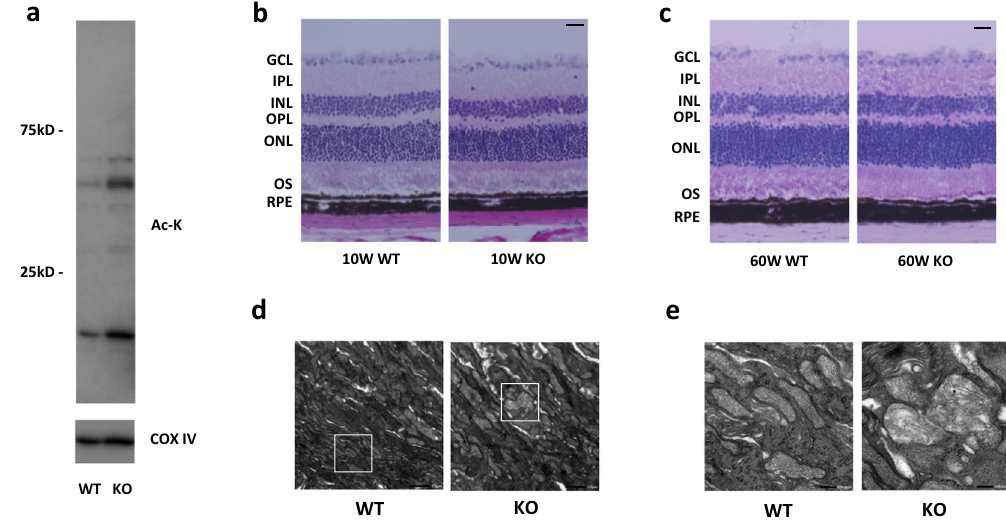
Fig. 2 SIRT3 KO retinas showed increased acetylated protein and damaged mitochondria. a Representative images of Immunoblot of mitochondrial fraction isolated from 10-week-old WT and SIRT3 KO retinas against Acetylated-Lysine (Ac-K). b , c Representative HE staining images of b young (10 weeks old) and c old (60 weeks old) WT and SIRT3 KO mice retinas. Scale bars: 20 μ m. GCL ganglion cell layer, IPL inner plexiform layer, INL inner nuclear layer, OPL outer plexiform layer, ONL outer nuclear layer, OS outer segment, RPE retinal pigment epithelium. d , e Electromicroscopy analysis of the morphology of mitochondria in the photoreceptor inner segments of 10-week-old WT and SIRT3 KO retinas. Mitochondria of WT retinas exhibited regularly spaced and densely packed cristae, whereas mitochondria of SIRT3 KO retinas exhibited sparse with irregularly arranged cristae. Scale bars: d 1 μ m e 200